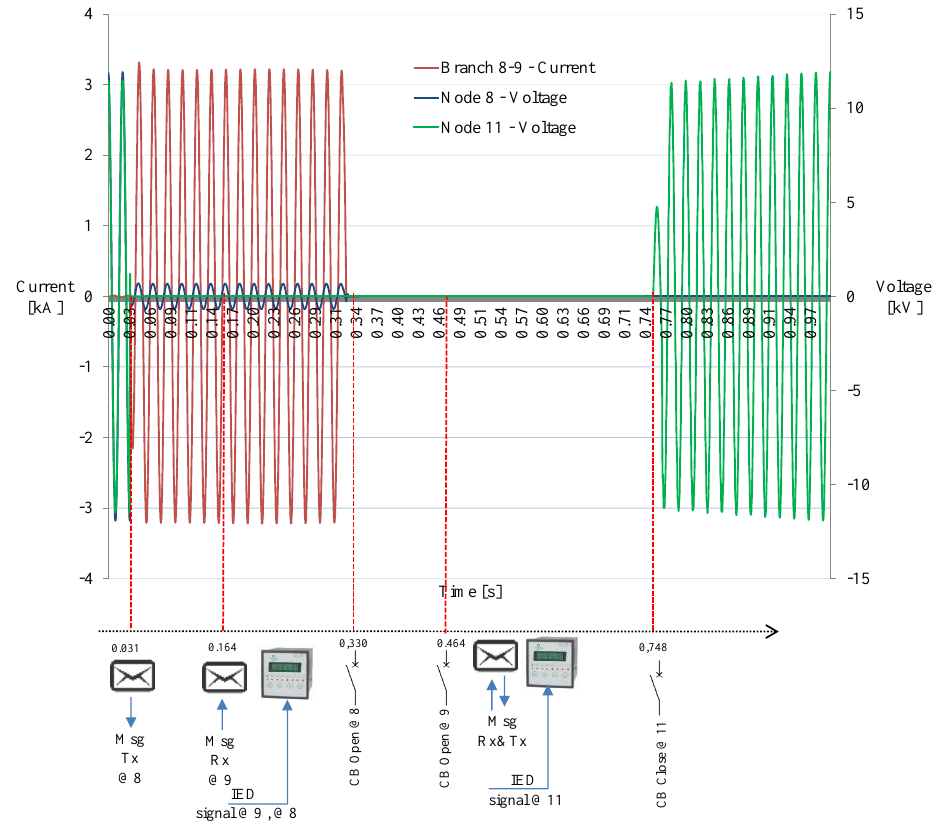
Figure 9. Voltage/current profiles: Voltage profile at node 8, and current profile in branch 8–9.